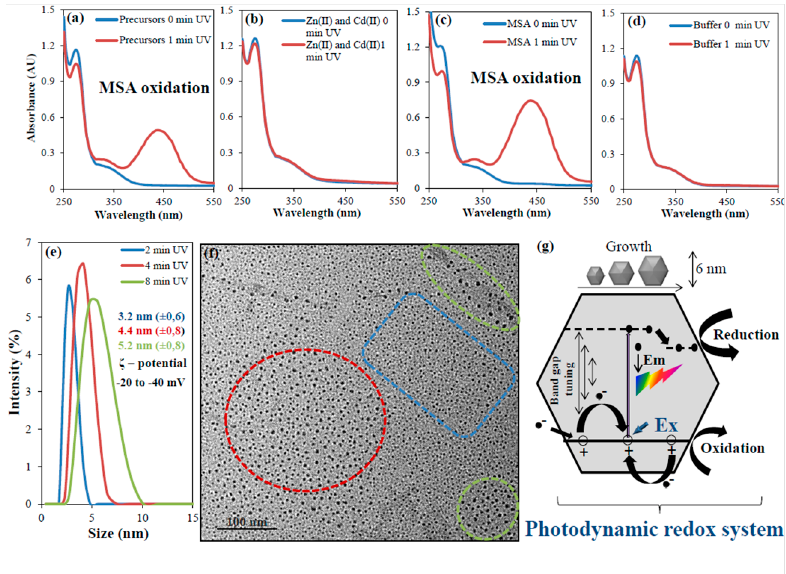
Figure 1. Monitoring of behavior of individual components of the precursor mixture. UV/Vis absorption spectra of tetrazolium salt producing a formazan dye upon reduction by a superoxide anion generated by photodissociation (photo-oxidation) of thiols (MSA) before (blue) and after (red) 1 min UV irradiation, the sample consisted from precursors ( a ) Zn(II), Cd(II) and MSA in pH 7 controlled by phosphate buffer, ( b ) Zn(II), Cd(II) in phosphate buffer pH 7, ( c ) solution of MSA in phosphate buffer pH 7 and ( d ) phosphate buffer pH 7 solution. QDs (quantum dots) characterization according to ( e ) size distribution of ZnCd QDs in range 3–5 nm after 2 (blue), 4 (red) and 8 (green) min UV irradiation and respective zeta potential in range the − 20 to − 40 mV, ( f ) Transmission electron micrograph of ZnCd QDs after 8 min UV irradiation of precursors (Zn:Cd:MSA in phosphate buffer pH 7), scale bar represents 100 nm. ( g ) Schematic representation of the proposed photodynamic redox system. Excited electrons (-) have a strong reduction potential and holes (+) are very strong oxidizing agents. Oxidation-reducing properties of ZnCd QDs can be significantly changed according to the band gap distance ( ↔ ) associated with growing of QDs.